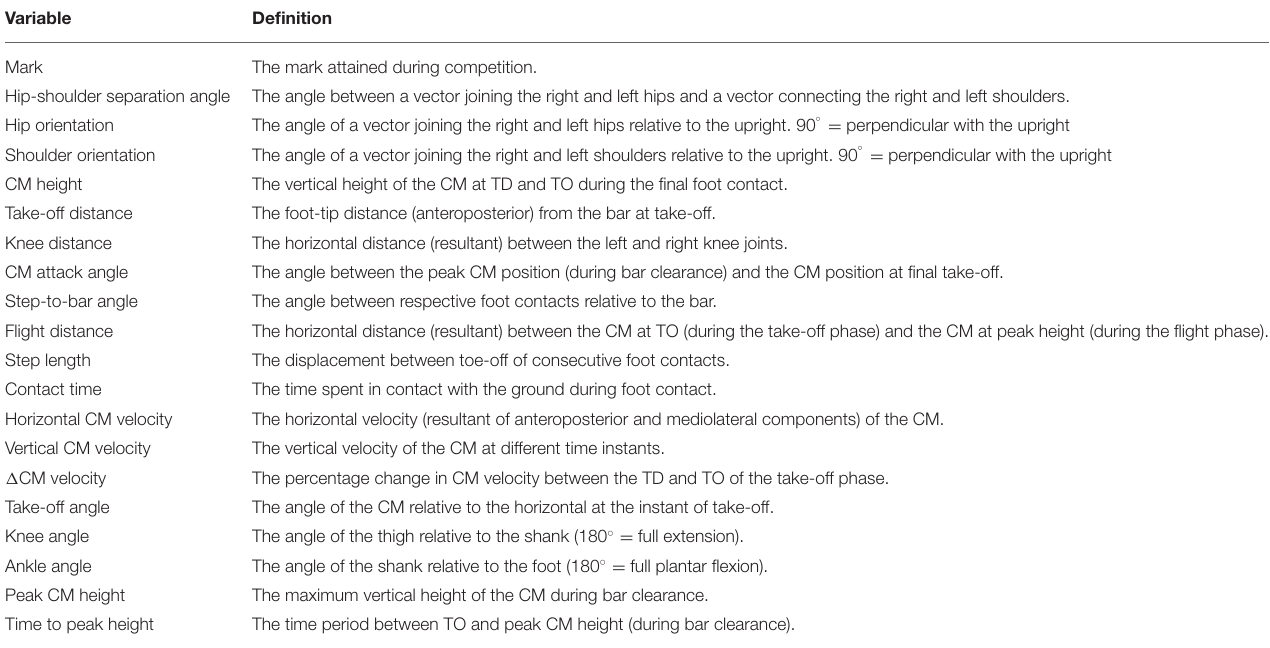
TABLE 1 | Definitions for all variables analyzed.